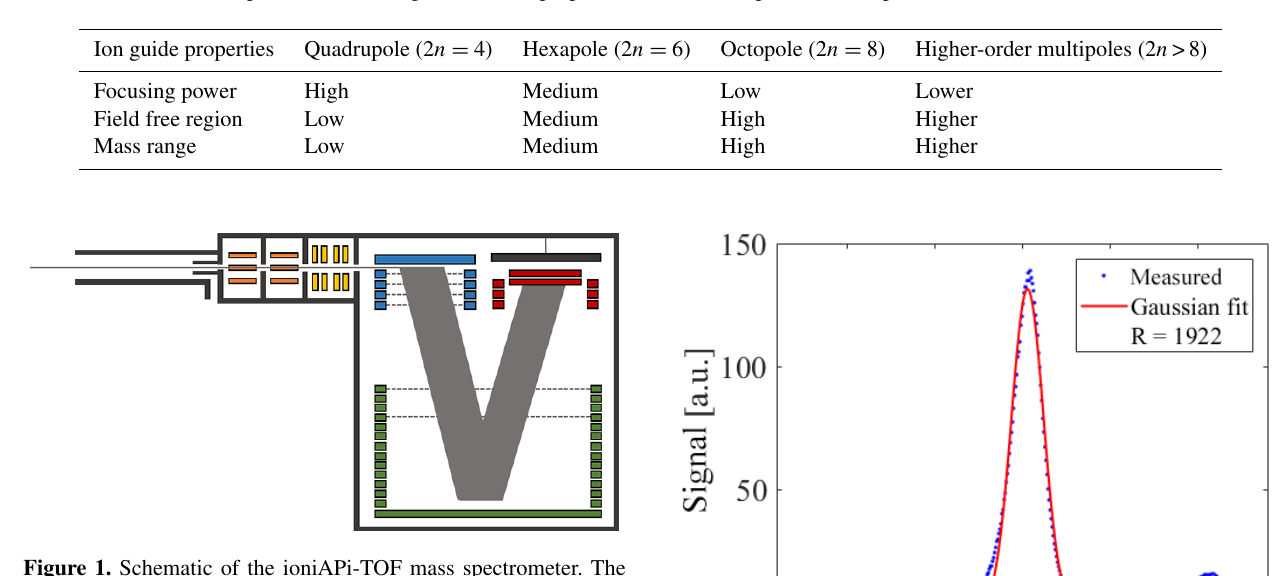
Figure 1. Schematic of the ioniAPi-TOF mass spectrometer. The hexapoles are shown in orange and the ion optical lens system in yellow. The orthogonal extraction region is coloured in blue. The reflectron is coloured in green and the detection region with post acceleration and MCP in red.